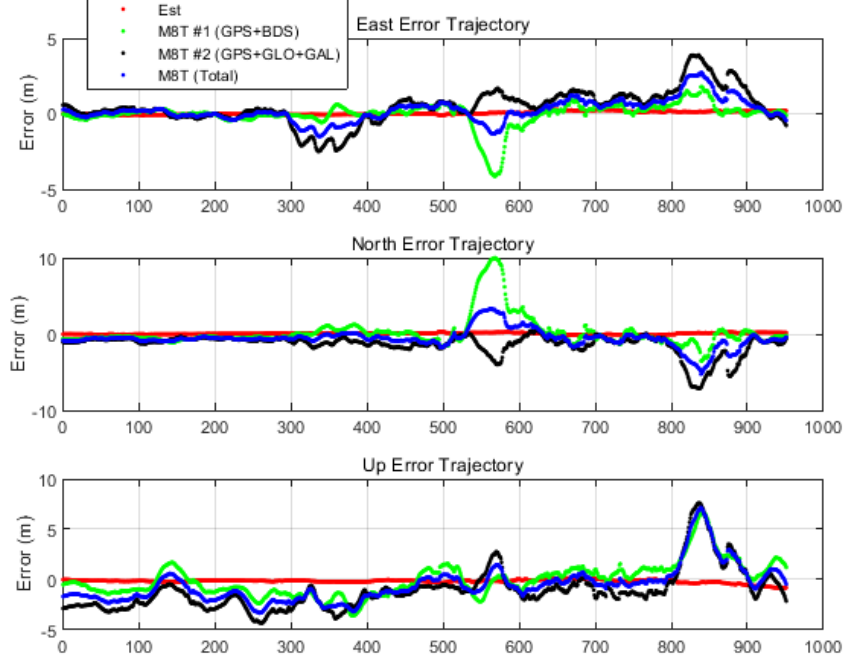
Figure 14. Time history of ENU errors with filtered solutions.